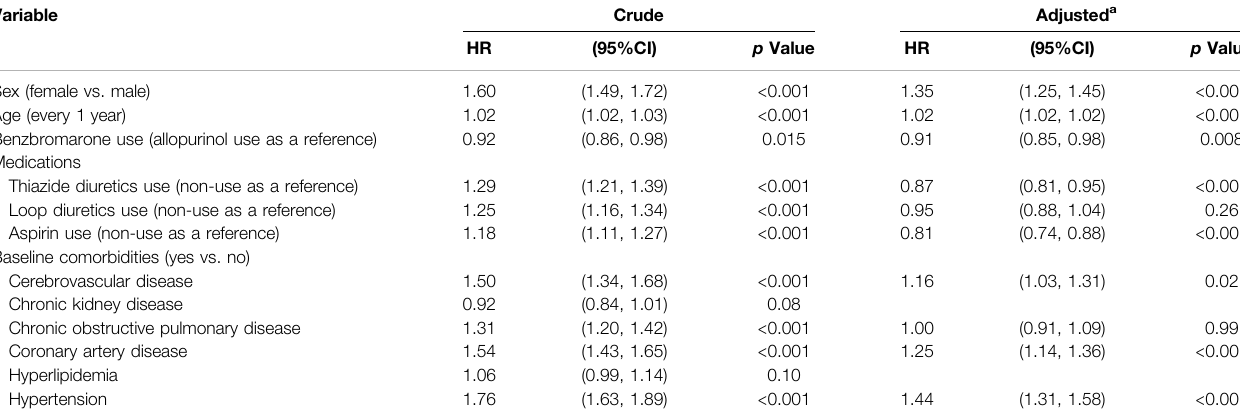
TABLE 4 | Hazard ratio and 95% con fi dence interval of type 2 diabetes associated with medications and comorbidities by the Cox proportional hazard regression model. Variable